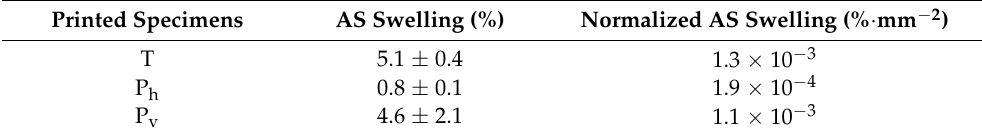
Table 2. Swelling of artificial saliva of the 3D printed PCL